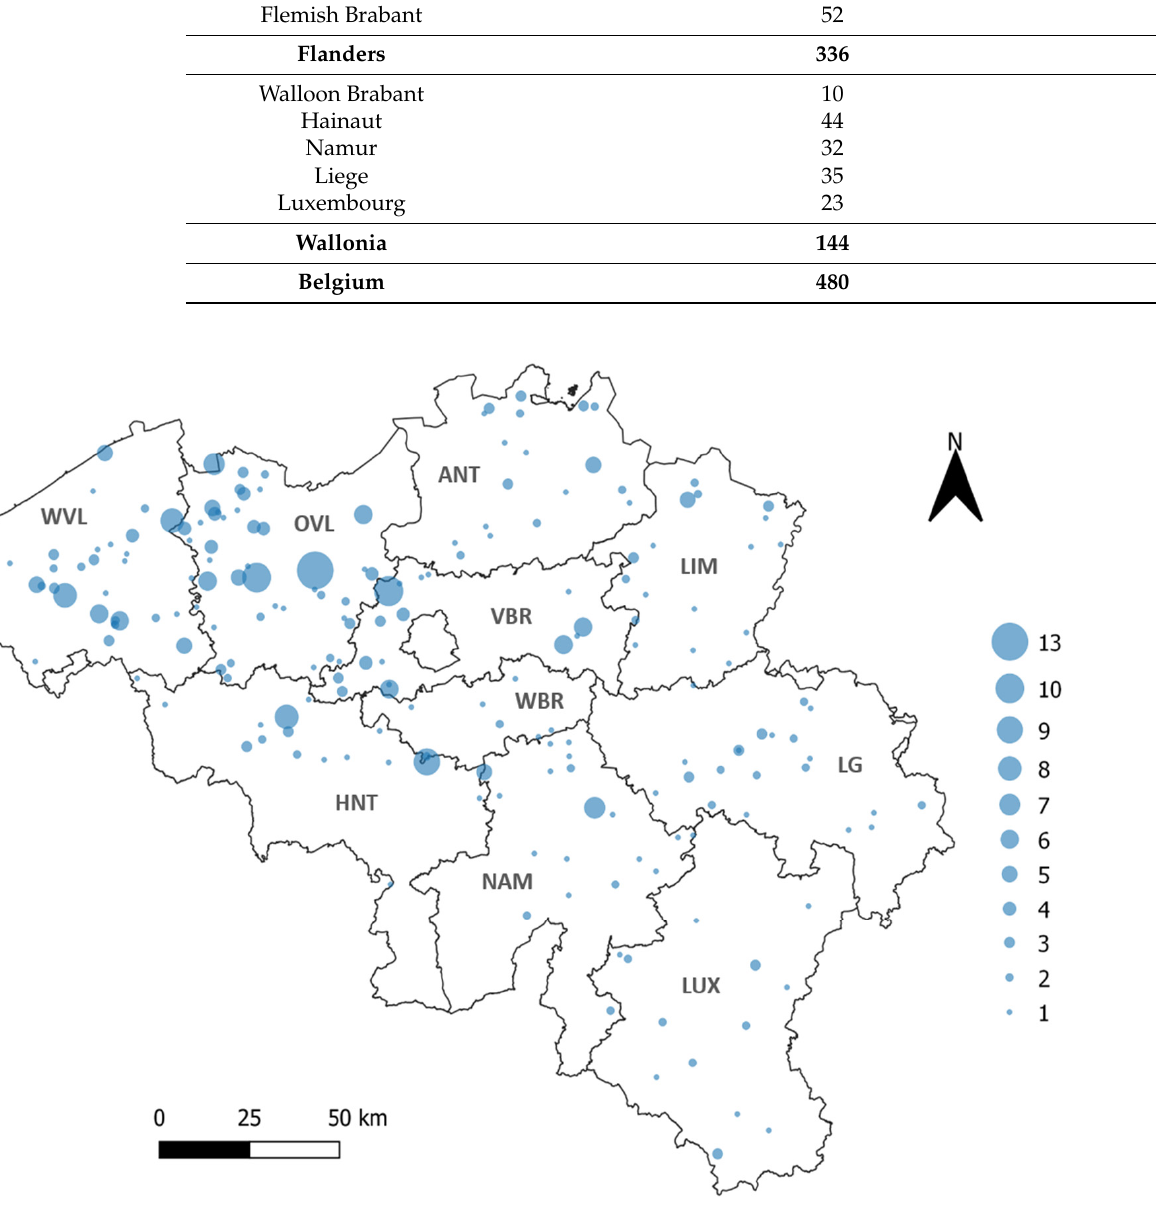
Figure 1. Geographical repartition of sheep samples (indicated with blue circles). The 10 Belgian provinces are indicated in bold. WVL: West Flanders, OVL: East Flanders, ANT: Antwerp, LIM: Limburg, VBR: Flemish Brabant, WBR: Walloon Brabant, HNT: Hainaut, NAM: Namur, LG: Liege, LUX: Luxembourg. The size of the blue circle corresponds to the number of samples per farm (from 1 to 13 samples).